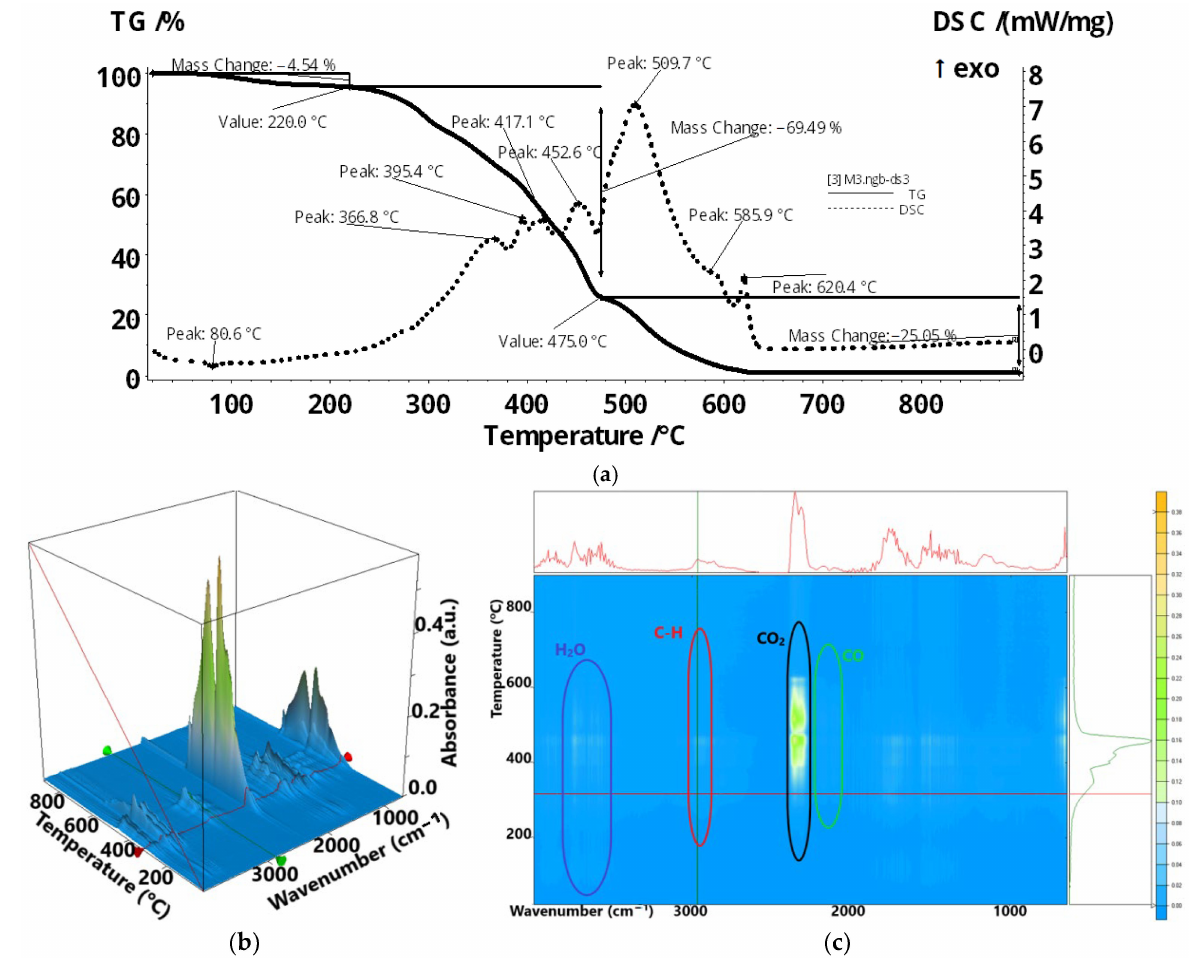
Figure 10. Thermal characteristics of the sEPDM membrane: ( a ) thermal diagram; ( b ) 3D complex analysis; ( c ) 2D complex analysis. (Reprinted from Ref.